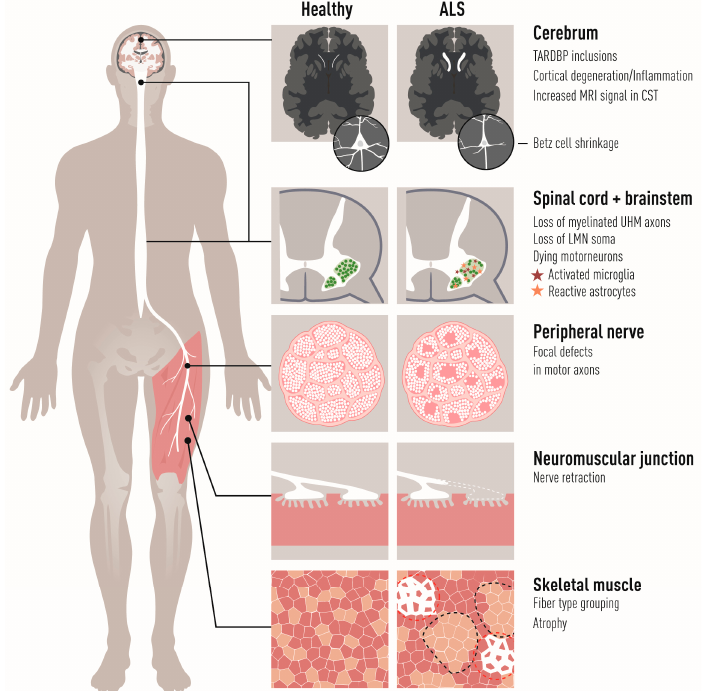
Figure 1. The pathology of ALS encompasses all levels of the voluntary neuromuscular system and involves multiple cell types. The primary targets of ALS are motor neurons in the cortex, brainstem, and spinal cord. Neuropathological characteristics of most ALS cases are TDP43 inclusions in both neurons and glial cells. Neuroinflammation is raging throughout the nervous system with activated microglia and astrocytes seen wherever degeneration is occurring. The loss of upper and lower motor neurons is further evident from axonal degeneration and demyelination of the corticospinal tract as well as of the peripheral spinal nerves innervating skeletal muscles [2,3]. Denervation of neuromuscular junctions on affected skeletal muscle fibers have begun prior to clinical onset of any apparent motor deficit. While FF motor axons retract and degenerate, S motor neurons sprout and innervate endplates vacated by FF motor neurons. This new innervation results in fiber type switching and apparent grouping of muscle fiber types followed by atrophy of permanently denervated muscle fibers